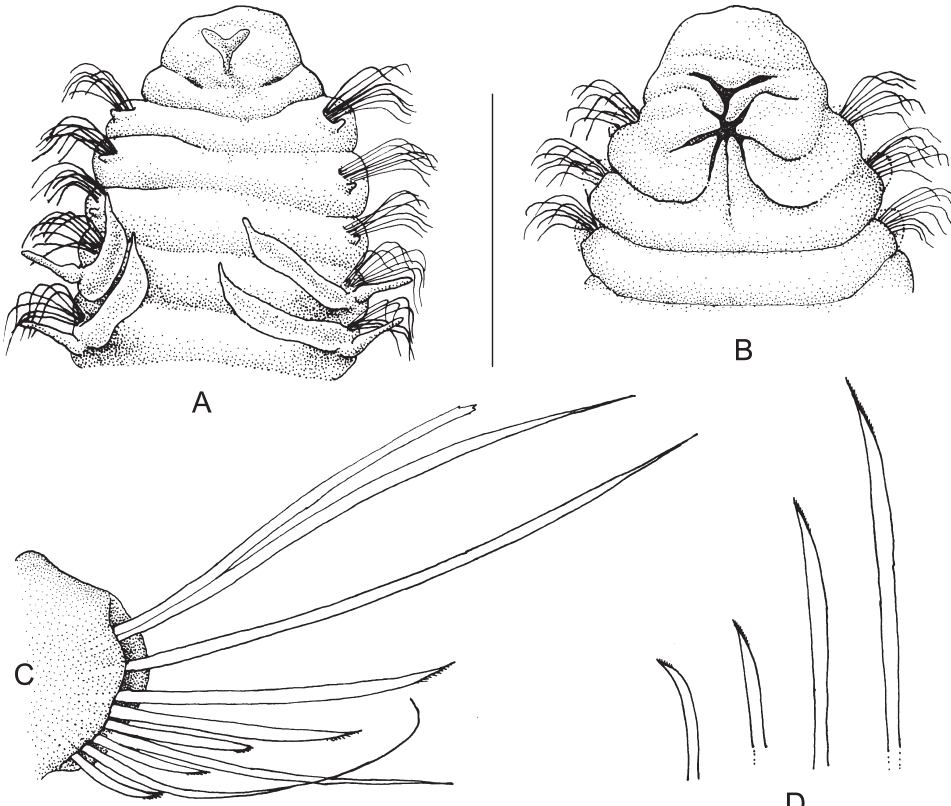
Fig . 16. – Aricidea ( Allia ) bifurcata n. sp. Holotype (Mncn 16.01/11207): A, anterior region, dorsal view; b, anterior region, ventral view; c, neuropodium, posterior chaetiger; D, modified ventral chaetae, posterior chaetiger. Scale bar: A 400 µ m; b 410 µ m; c 80 µ m; D 75 µ